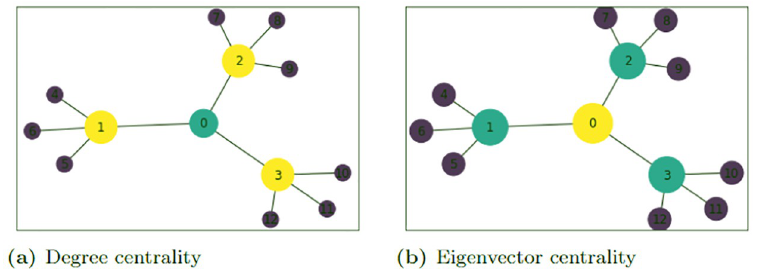
Fig 6. Degree and eigenvector centrality of a Graph. Identifying the importance of a node in a network based on (a) degree centrality and (b) eigenvector centrality. The color and radius of each disk around a node is dependent upon the centrality values. The least central nodes are colored in purple, the mid-central nodes are colored in green with the most central nodes colored yellow. Nodes 1, 2 and 3 have the highest values when using the degree centrality measure while node 0 has the highest value when using the EC measure.